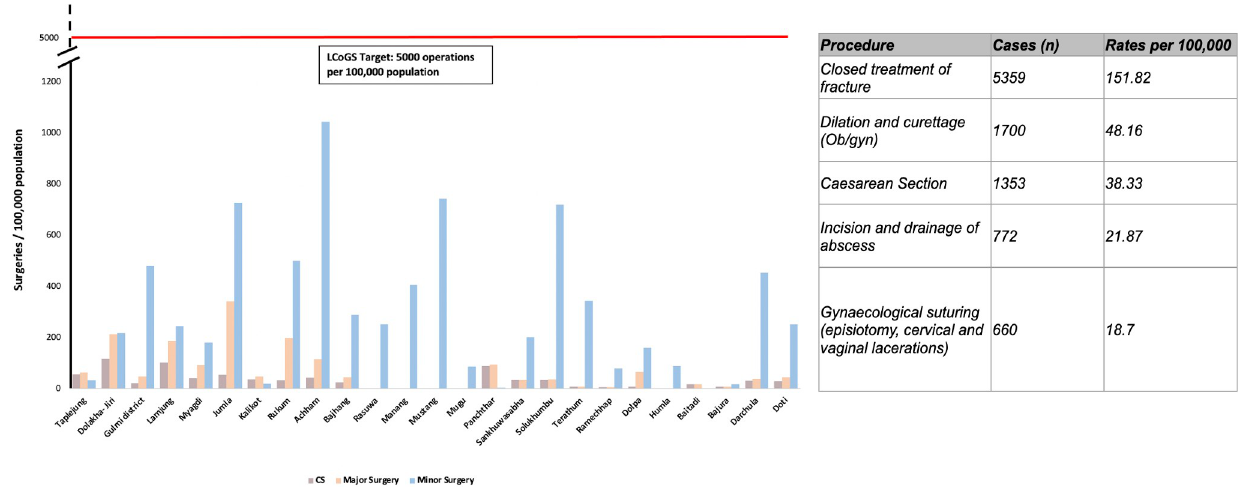
Fig 2. Surgical rates of bellwether procedures per study district, compared to lancet commission goals, and top 5 major operations performed in study district hospitals.